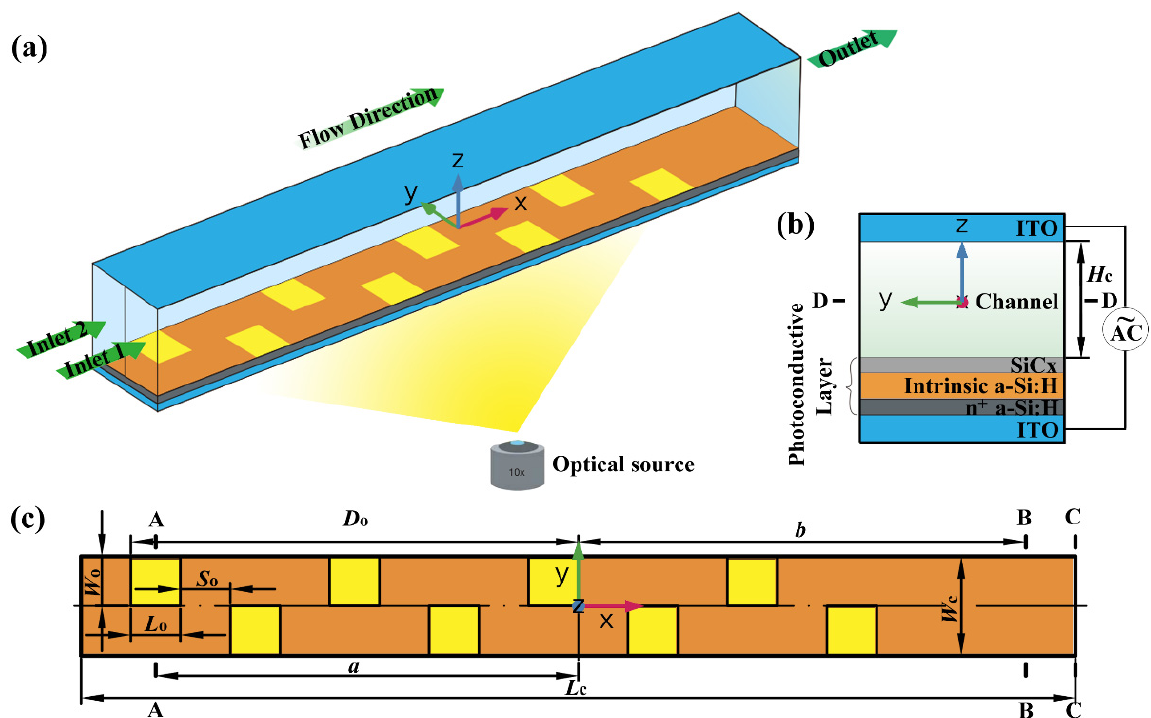
Figure 1. Microfluidic mixer with staggered virtual electrode based on LACE. ( a ) Three-dimensional structure of micromixer; green arrows indicate flow direction. ( b ) Cross-sectional (yz section) view of micromixer and photoconductive layer. ( c ) Top view of micromixer. Orange and yellow areas indicate photoconductive layer and the staggered light spots projected onto photoconductive layer, respectively. A–A, B–B, and C–C represent cross-section (yz section) at a distance of − 85, 90, and 100 µ m (exit position) from microchannel center, respectively. D–D represents section (xy section) at the microchannel center. Origin of the Cartesian coordinate system is located at the microchannel center.